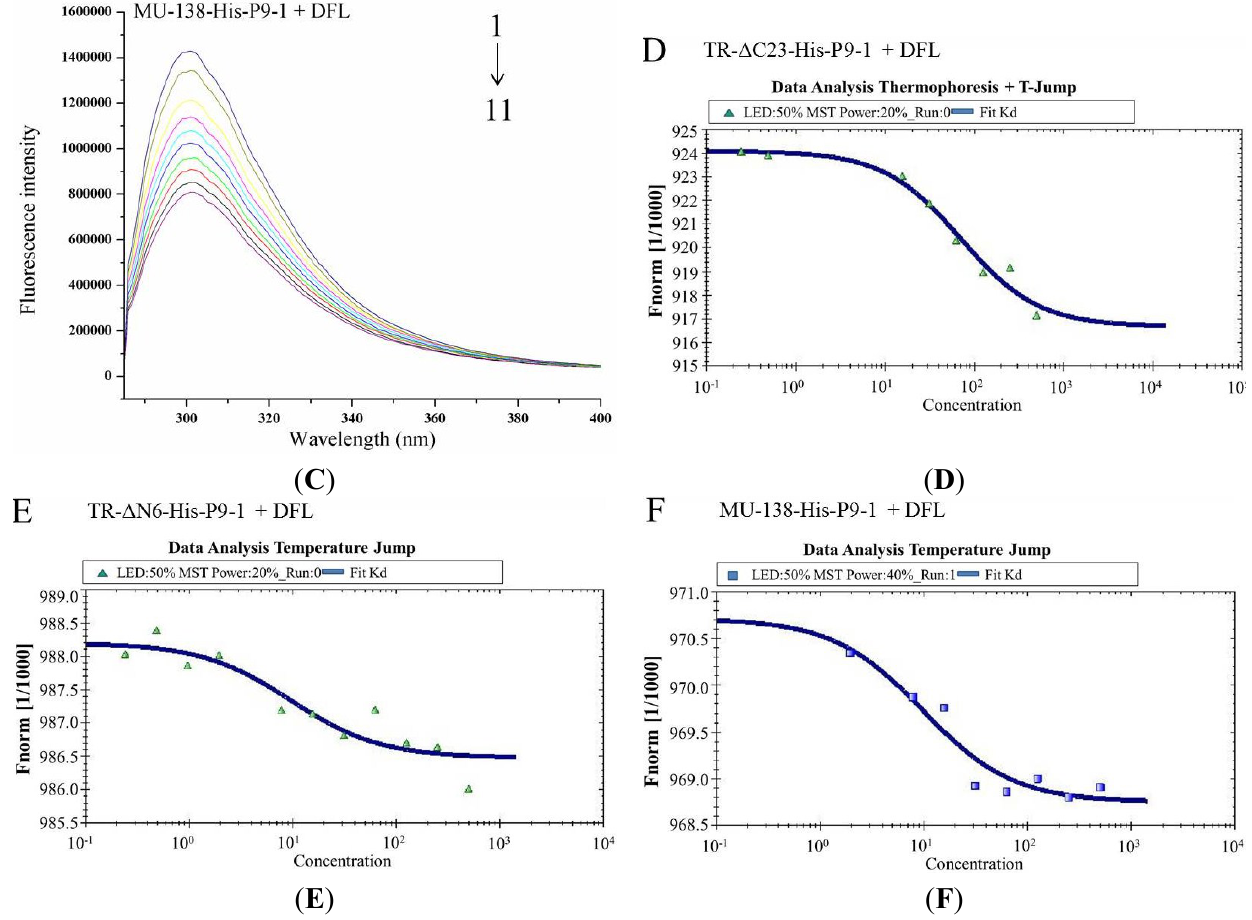
Figure 5. Binding affinity and specificity of DFL to mutagenesis P9-1